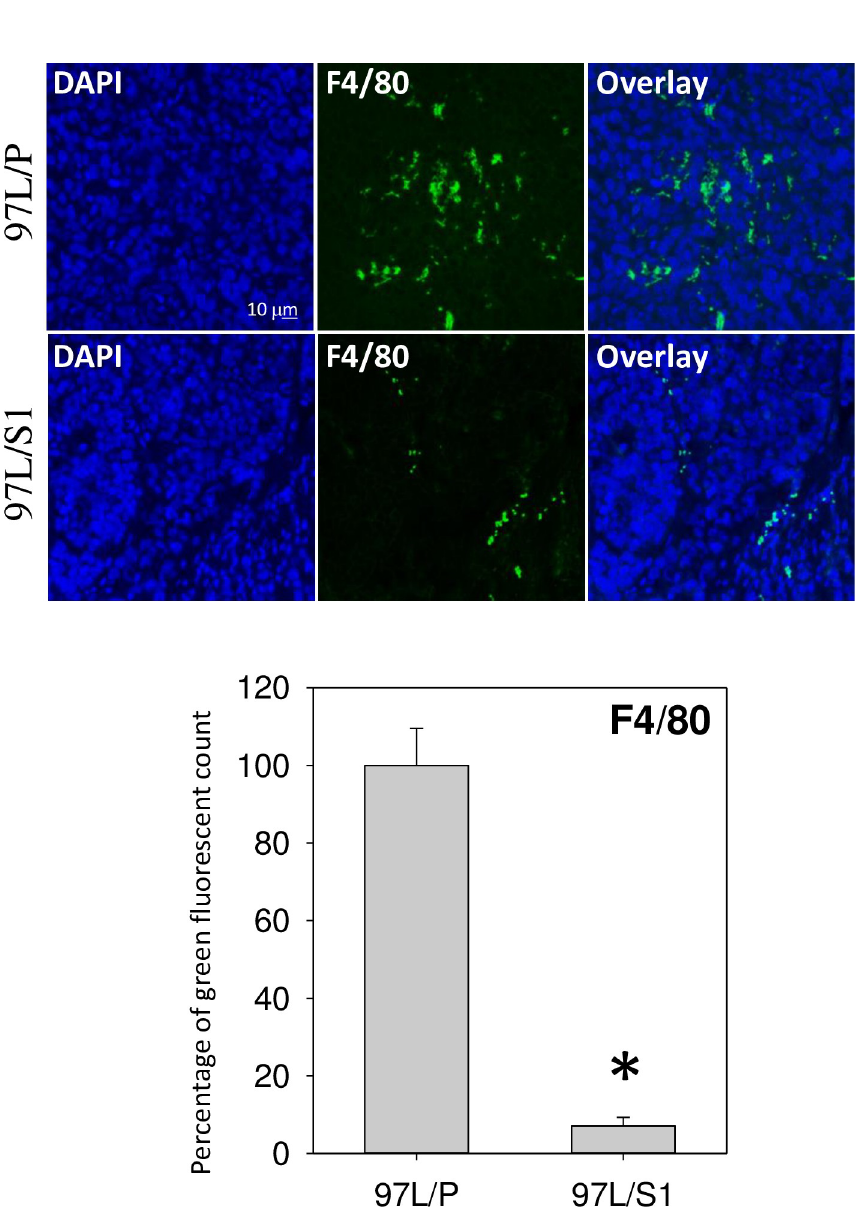
Fig 6. Immunohistochemical staining of xenograft tumor sections. Tumor mass derived from the inoculation of MHCC97/P and MHCC97/S1 cells in nude mice were collected for immunohistochemical staining of macrophage- differentiation marker F4/80. Infiltrated macrophages were stained in green (F4/80), and nuclei were in blue (DAPI). The percentage of the green fluorescent count was significantly higher in 97L/P tumors than that in 97L/S1 tumors ( � P <